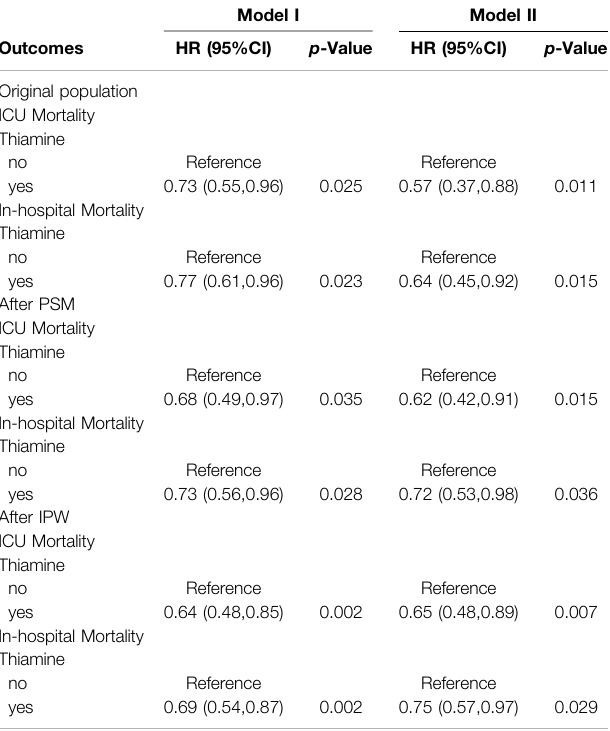
TABLE 2 | Results of Cox proportional hazard